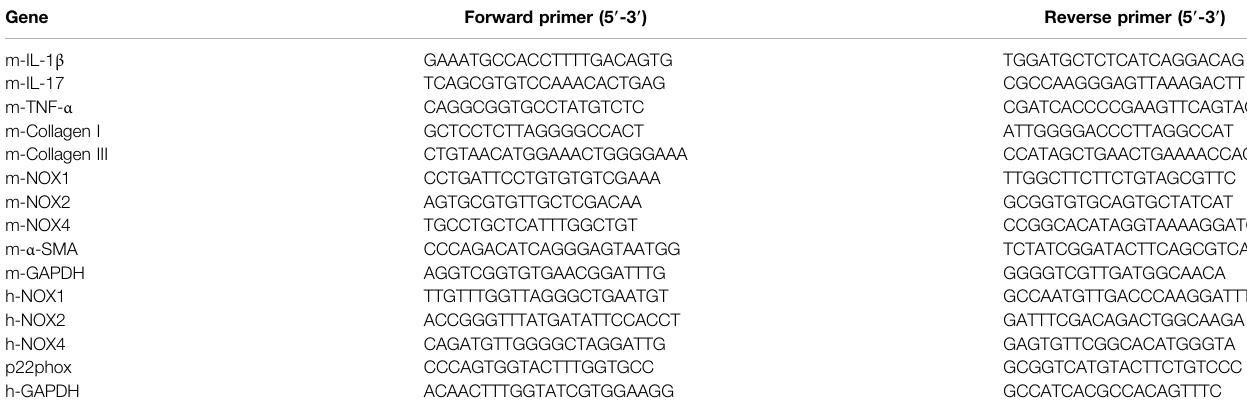
TABLE 1 | Primers used for quantitative real-time PCR analysis.